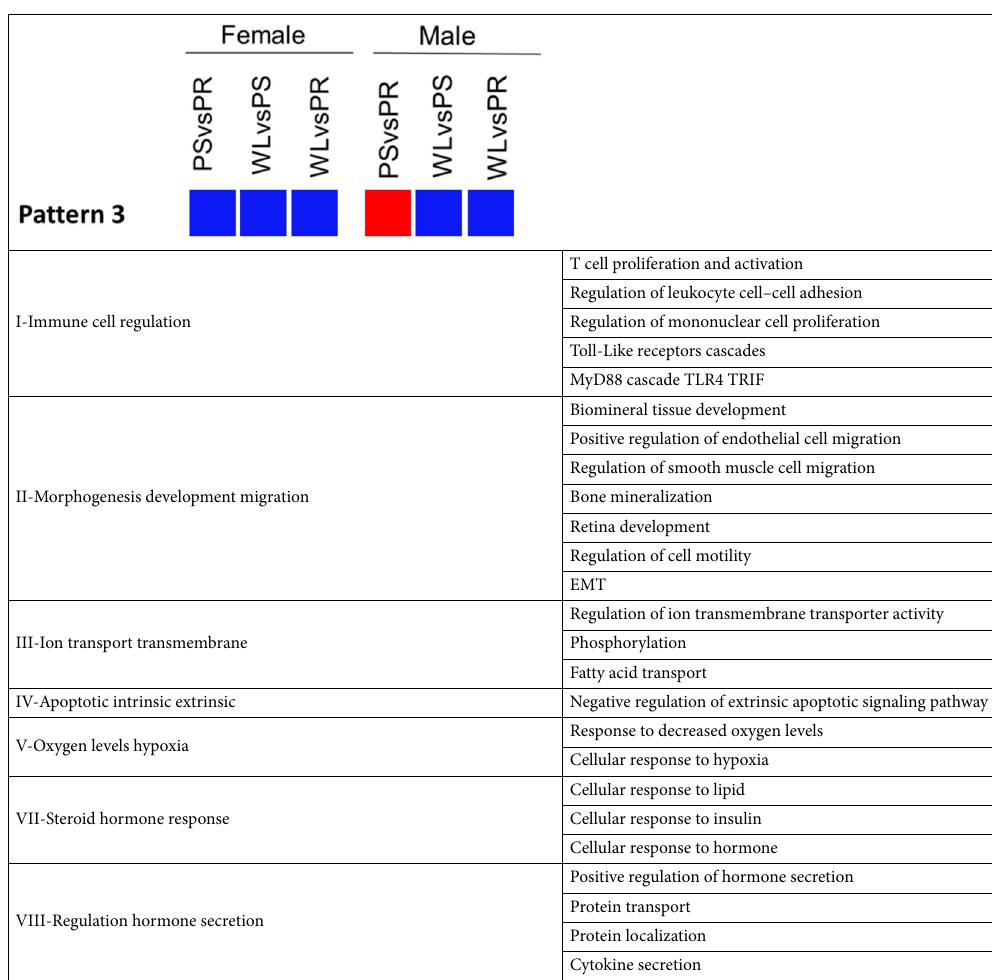
Table 3. Summary of clusters and gene sets included in the pattern 3 for the renal IRI time